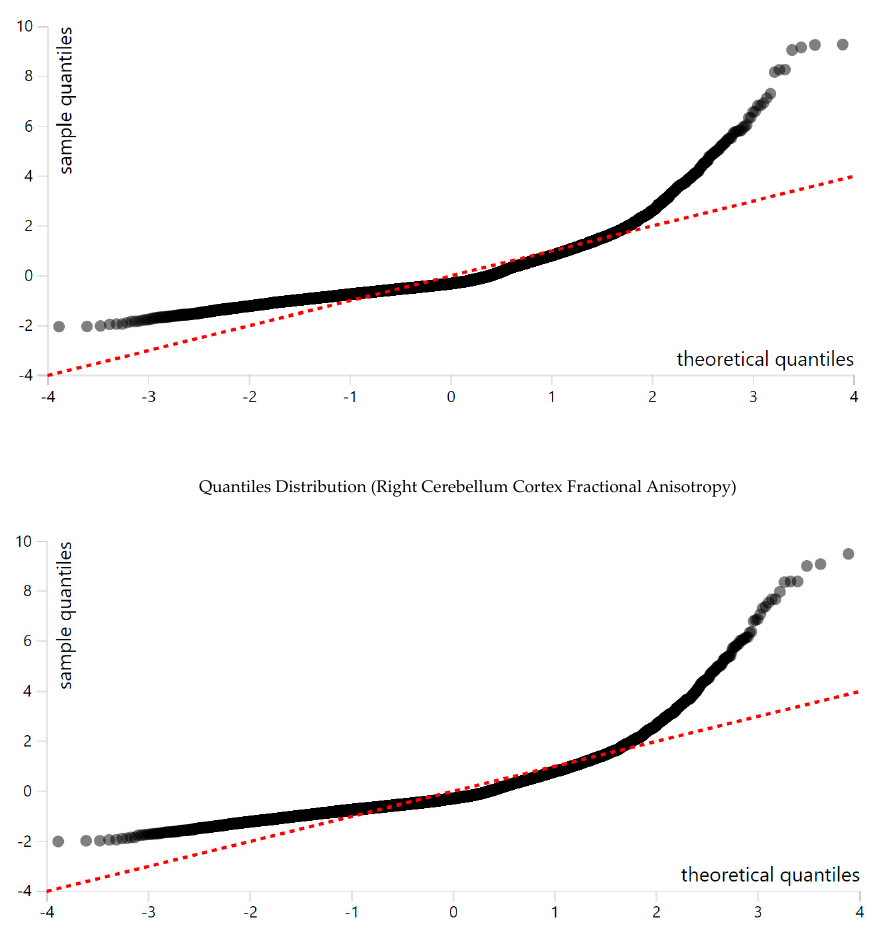
Figure A1. Models Assumptions.